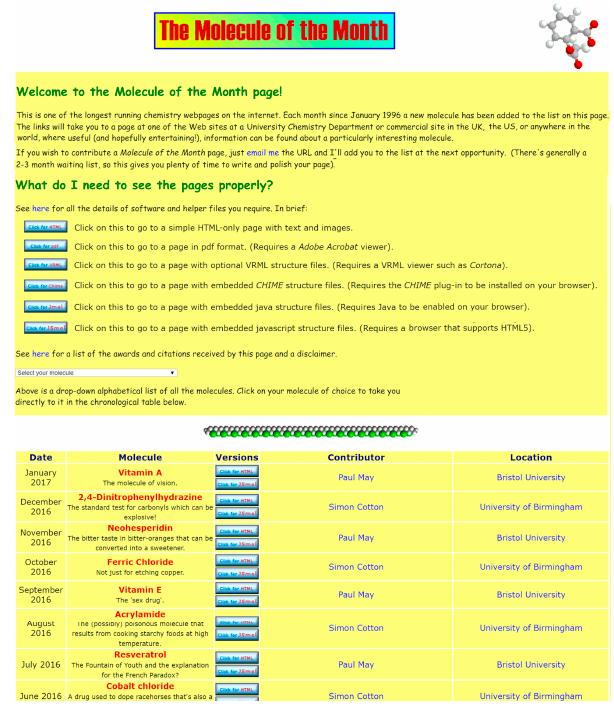
Figure 4. The landing page of the MOTM website [3] as it appeared in January 2017.